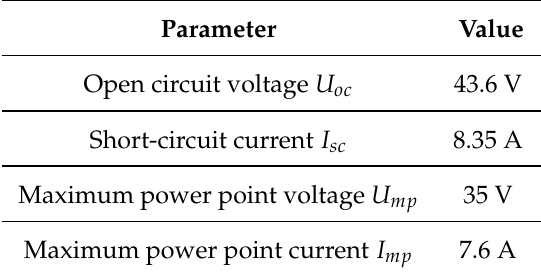
Table 5. The chart of PV array’s parameter settings.